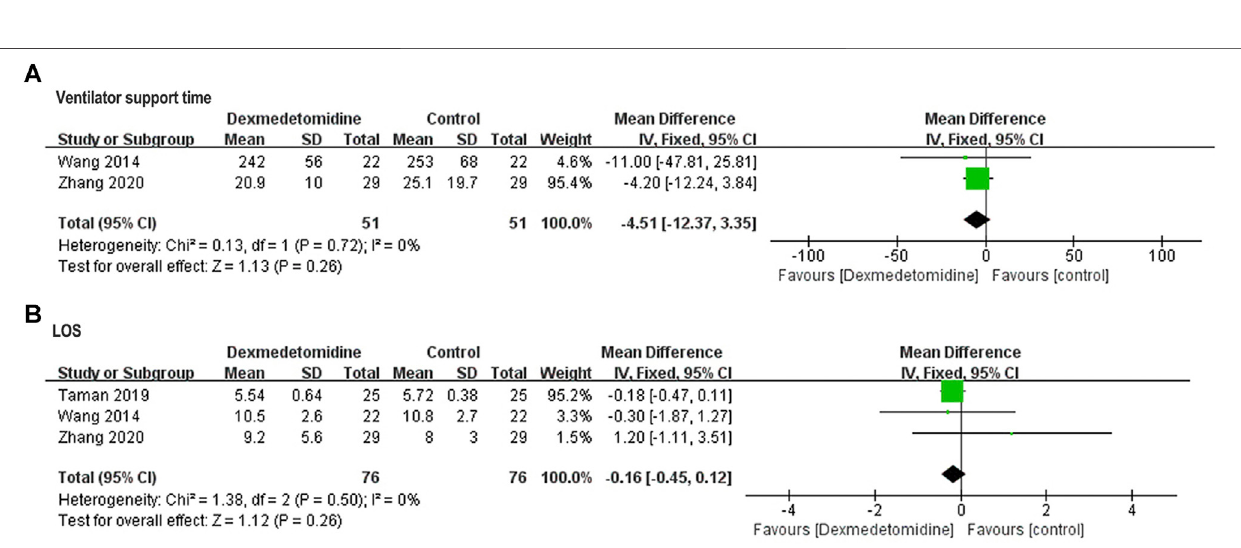
Frontiers in Pharmacology |